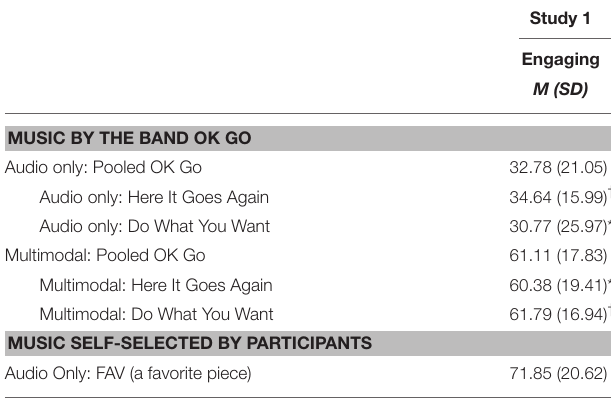
TABLE 2 | Mean subjective rating elicited by each musical stimulus, and by each category of musical